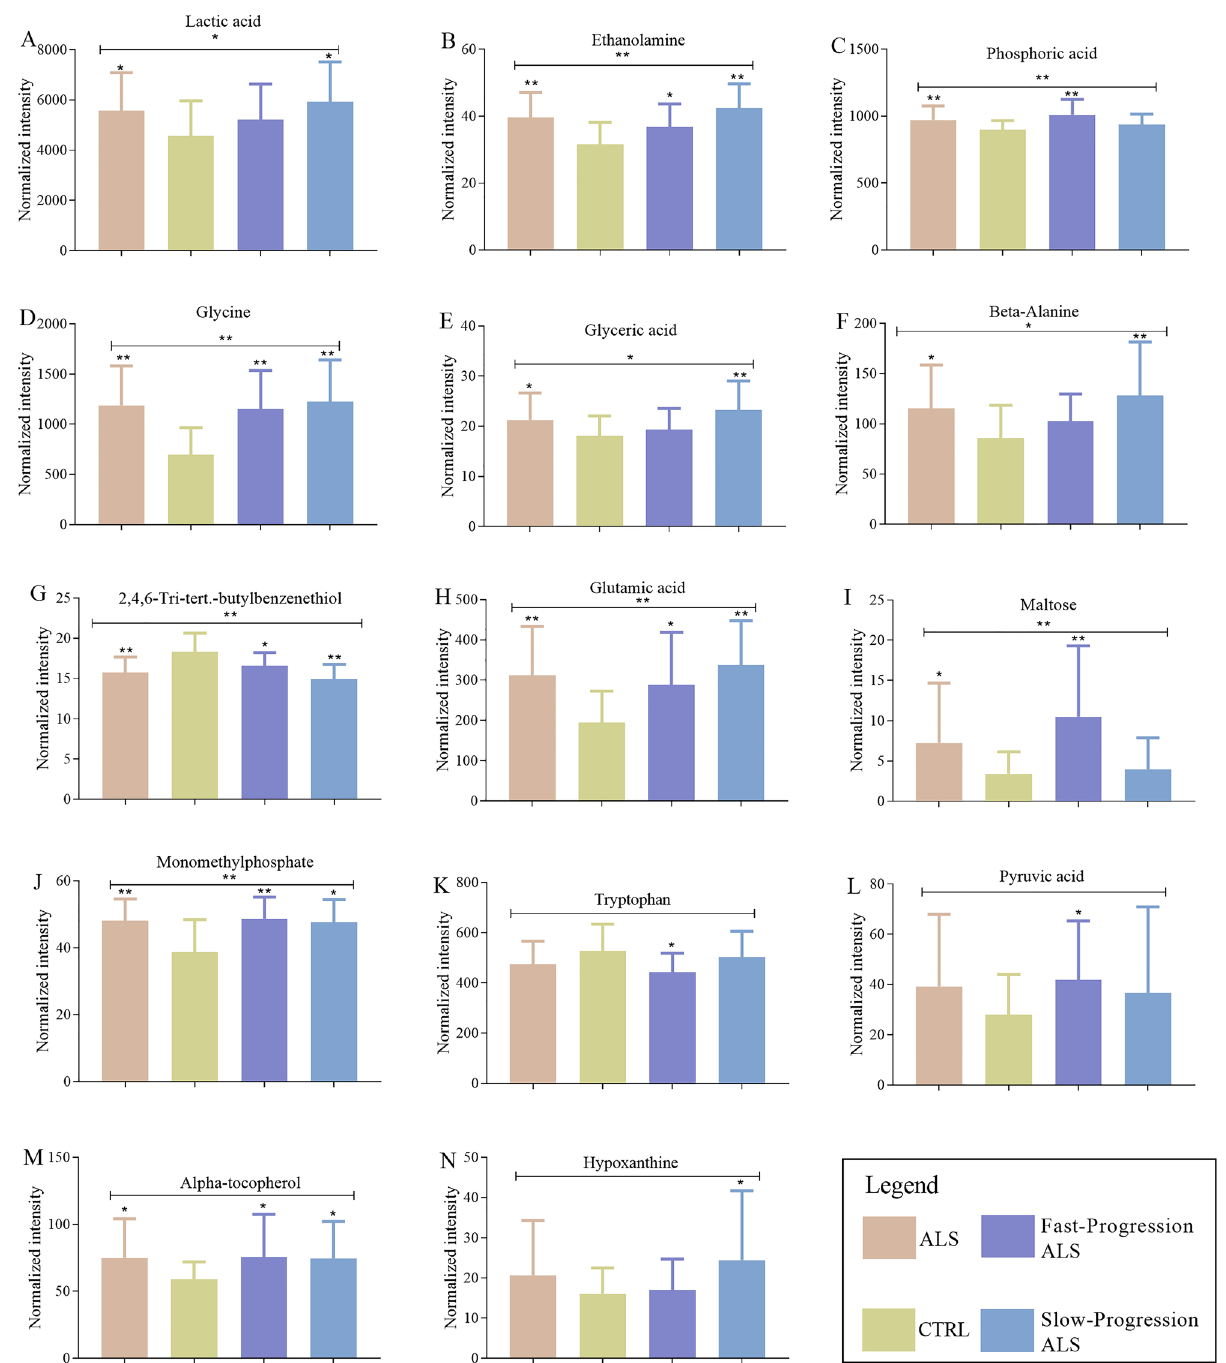
Figure 3. The analysis of each differential metabolites among ALS, ALS subgroups and CTRL. ( A – N ) The AVONVA analysis was used to compare each metabolite among ALS, CTRL, Fast-progression ALS and Slow- progression ALS; The Student’s t -test was used to compare each metabolite between the ALS and CTRL, Fast- progression ALS and CTRL, Slow-progression ALS and CTRL respectively. * p < 0.05; ** p < Plasma samples have been widely used to identify differential metabolites and metabolic pathways 26,27 . Cie- slarova et al. 27 measured the plasma levels of homocysteine, cysteine, methionine, and glutamic acid in ALS patients using capillary electrophoresis tandem MS, and found that glutamic acid and homocysteine might be potential biomarkers for ALS. Lawton et al. 26 found that the plasma concentrations of 23 metabolites were signifi- cantly changed in ALS patients as well as the associated pathways including neural, hypermetabolism, oxidative damage, and mitochondrial dysfunction. Compared with plasma samples, blood has less effects on the analyte peak areas of serum specimens; therefore, serum is a better choice for metabolomic analysis 28 . In this study, we